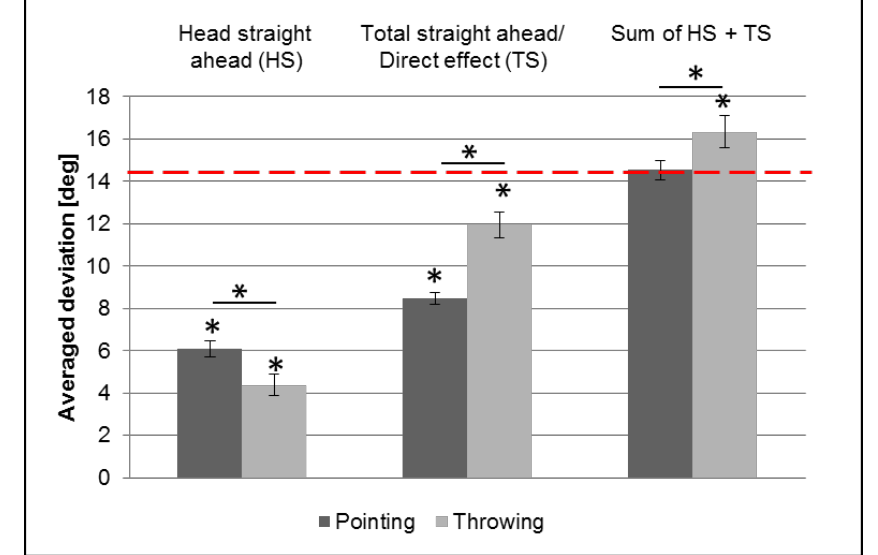
Figure 1. Head straight ahead, direct effect and sum of head straight ahead and direct effect after adaptive interval (before adaptive movements) in light (first interval test). The red dashed line on the y-axis indicates the optical power of the prisms. Error bars indicate SEs. * indicates p ≤ 0.05. Head rotation is larger for pointing, associated with a smaller direct effect caused by a larger immediate correction effect.